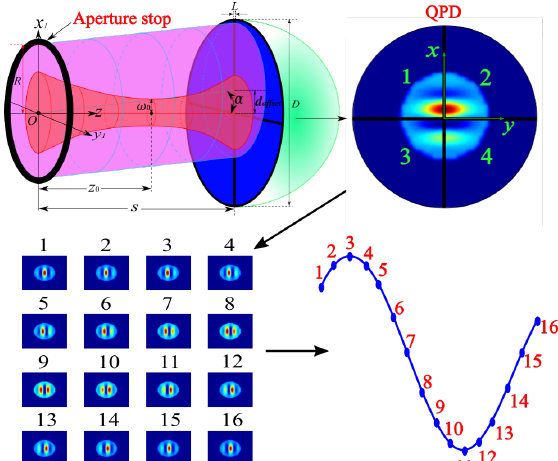
Figure 1. The upper part of the figure is a simplified schematic of an interferometer. Here, we set a Gaussian beam as the reference beam that propagates along the z axis and strikes the center of the detector; We also set a flat-top beam as the measurement beam that is tilted by an angle α around the y axis, and to simplify the calculations, we set its pivot as the coordinate origin O . The aperture stop is placed at the coordinate origin and is perpendicular to the z-axis and R is its radial dimension. s is the position of the QPD. d of fset is the distance between the centers of the two beams. z 0 is the waist position. D and L are the diameter size and the gap size of the QPD, respectively. The interference pattern per sampling on the detector shown as the left side of the lower part of the figure, is respectively summed over the area of detector to acquire a beat signal shown as the right side. The signal-processing tool based on MATLAB then can process the beat signal to obtain the phase